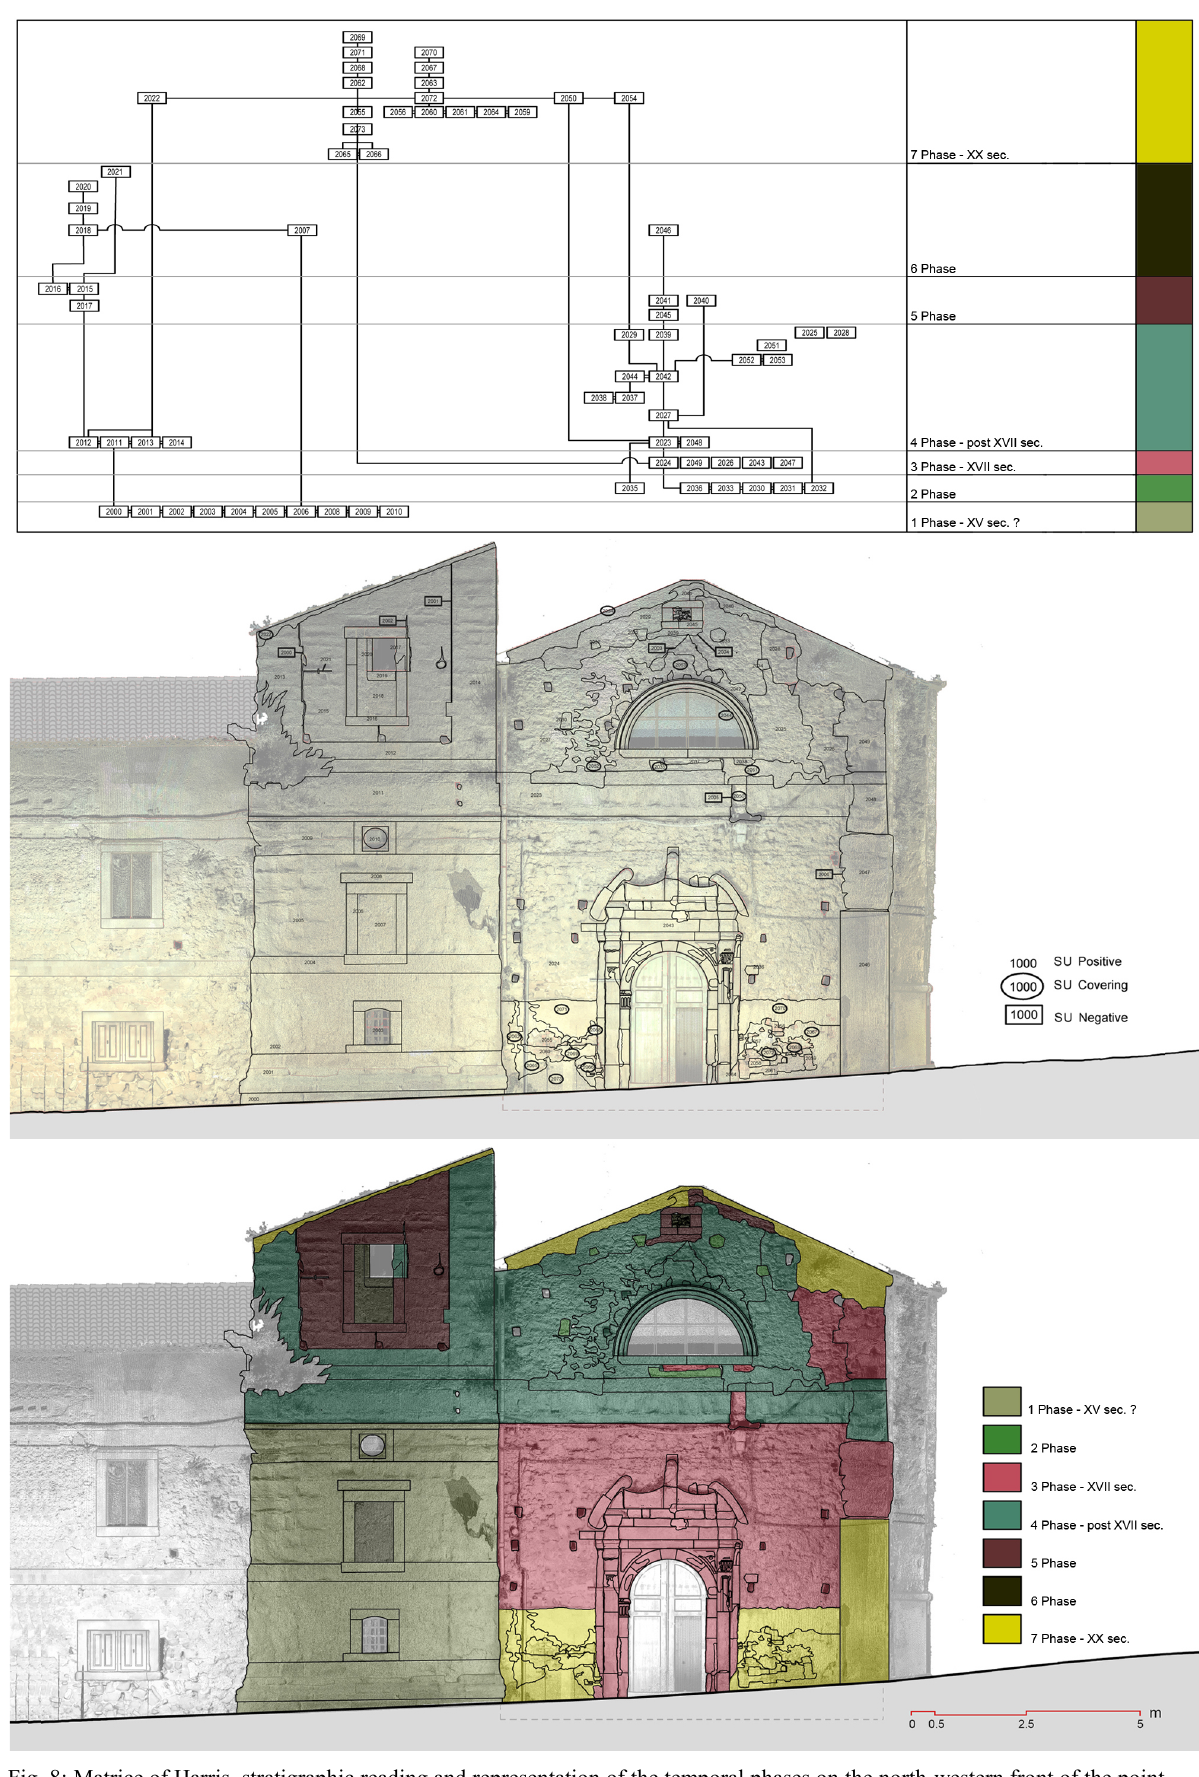
Fig. 8: Matrice of Harris, stratigraphic reading and representation of the temporal phases on the north-western front of the point cloud